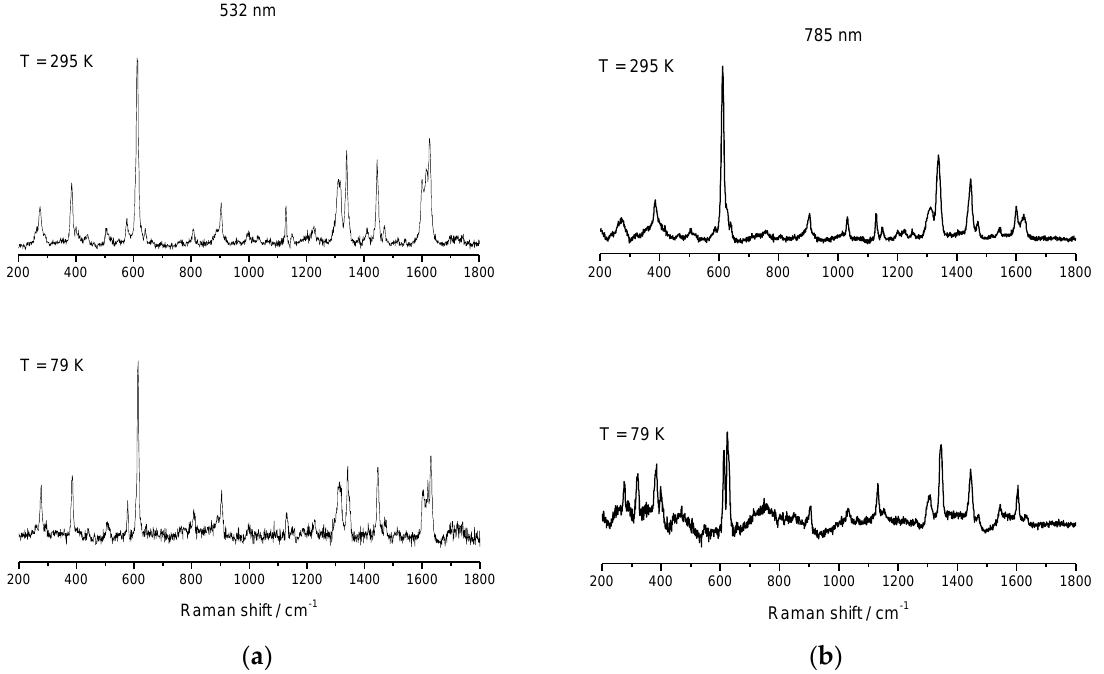
Figure 11. Variable temperature rRaman spectra of [FeL 1C18 ]BF 4 , ( 3 ), using laser excitation of 532 nm ( a ) and variable temperature Raman spectra of [FeL 1C18 ]BF 4 , ( 3 ), using laser excitation 785 nm ( b ).